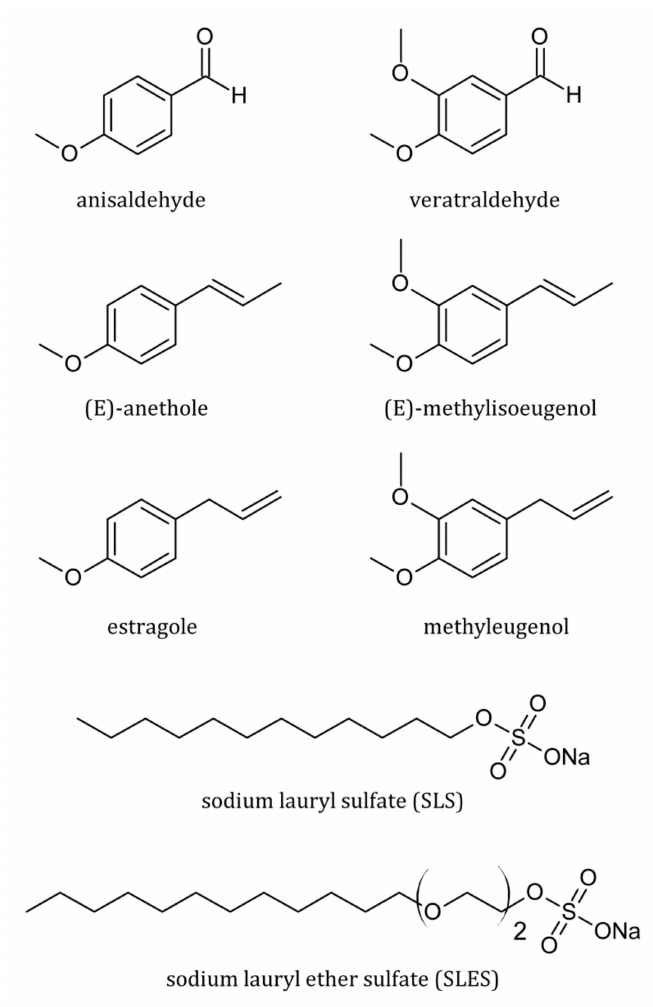
Figure 1. The molecular structure of studied fragrance materials and